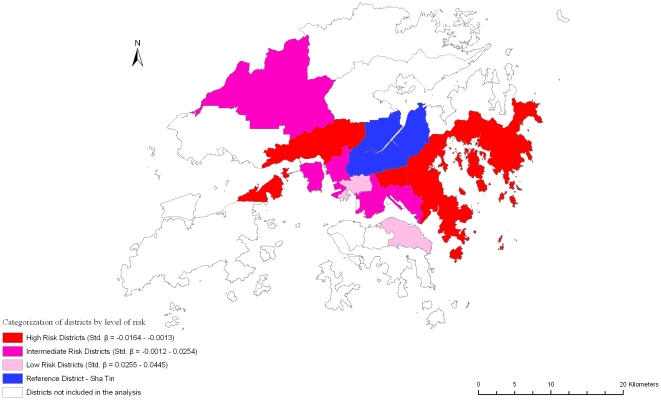
Risk variation in self-rated physical health (SF-12 physical) across districts.